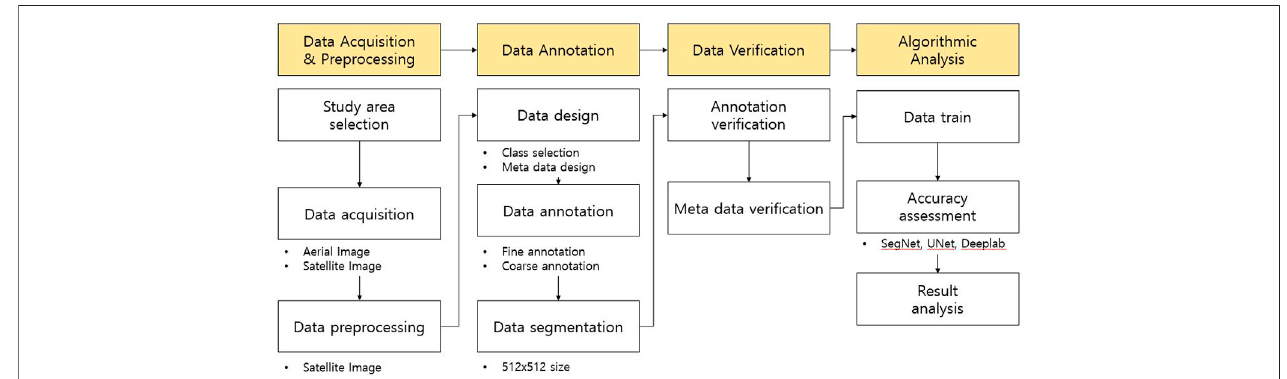
FIGURE 1 | Flow chart in this study.